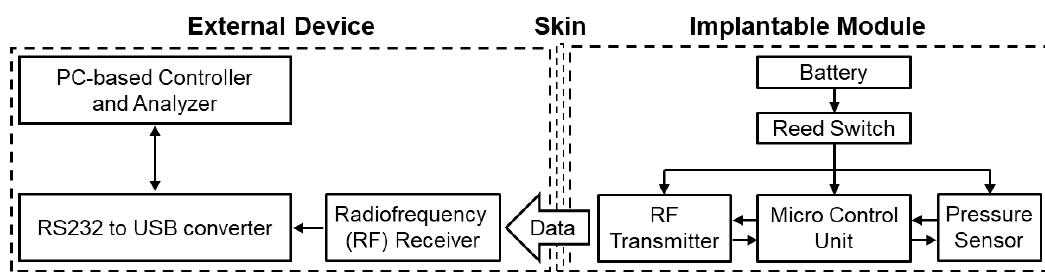
Figure 1. System block diagrams of the wireless implantable biomicrosystem for bladder pressure monitoring. RF is defined as radiofrequency.